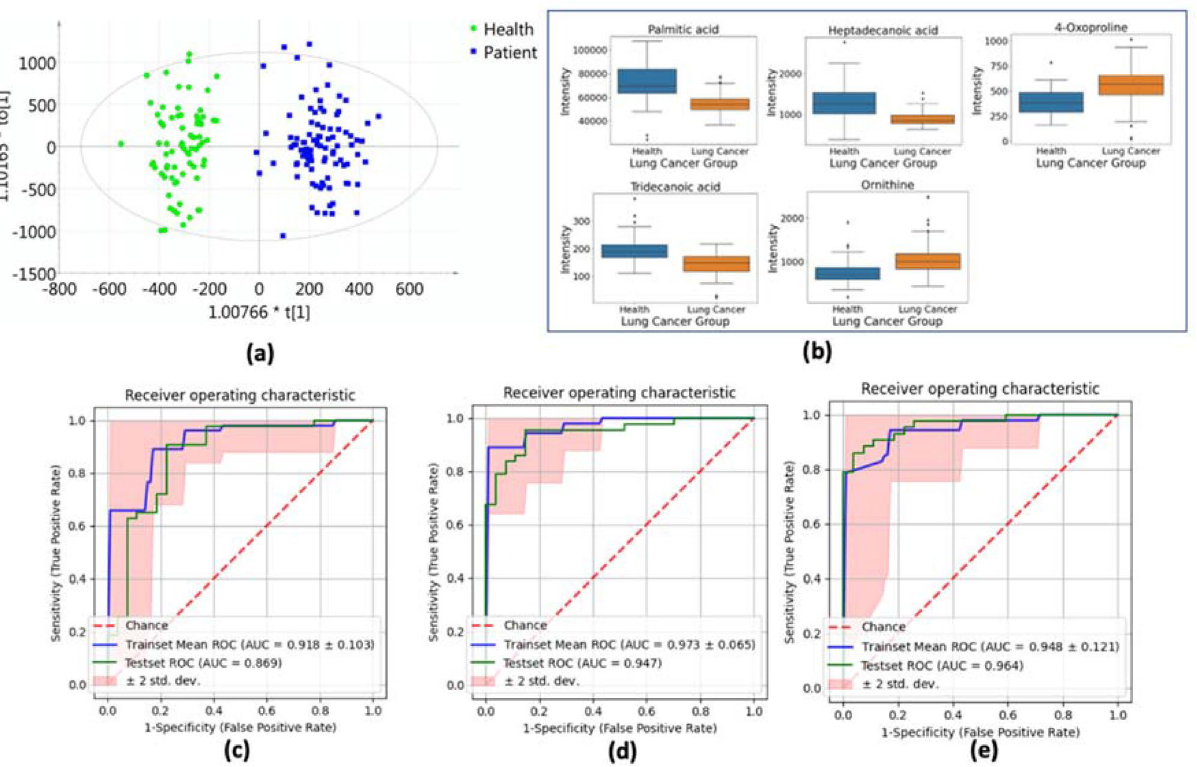
Figure 1. (a) Orthogonal projection on latent structure discriminant analysis (OPLS-DA) score plot shows the ability to separate lung cancer patients from healthy controls. (b) Box and whisker plots for the top 5 most important metabolites between healthy control and lung cancer groups. (c)-(e) Receiver-operating characteristic (ROC) curves for discriminating healthy controls and lung cancer patients [ (c) ROC curves of the logistic model using top 5 metabolomic markers; (d) ROC curves of the logistic model using top 10 metabolomic markers; (e) ROC curves of the logistic model using top 20 metabolomic markers].